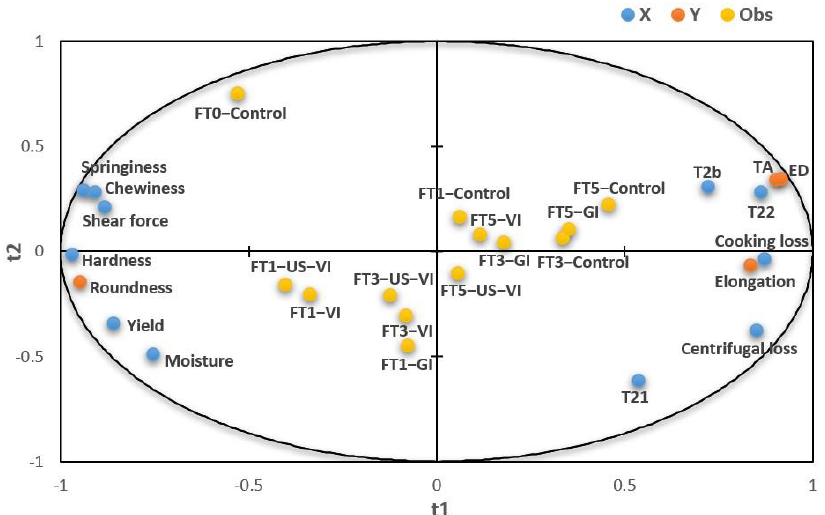
Figure 6. A correlation loading plot from a partial least squares regression (PLSR) model. (TA: average cross-sectional (transverse) area; ED: average equivalent diameter; FT1, FT3, FT5: numbers of freeze – thaw cycles.)